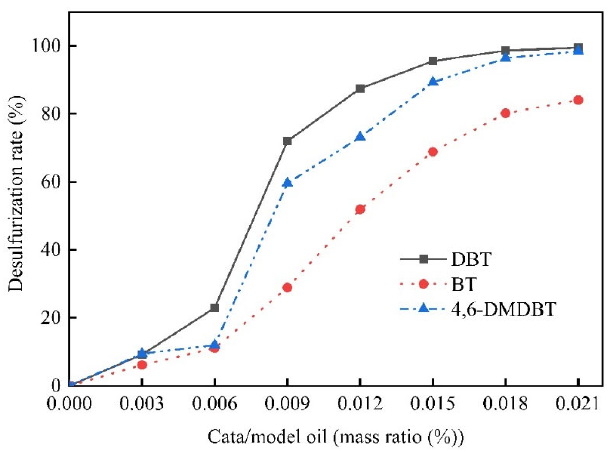
Figure 5. Effect of catalyst/ fuel oil on dibenzothiophene (DBT), benzothiophene (BT), and 4,6-dimethyldibenzothiophene (4,6-DMDBT) desulfurization. Reaction conditions for DBT desulfurization: v (H 2 O 2 )/ v (fuel oil) = 0.30%, 50 ◦ C, 5 min. Reaction conditions for BT desulfurization: v (H 2 O 2 )/ v ( fuel oil) = 0.30%, 50 °C, 8 min. Reaction conditions for 4,6 ‐ DMDBT desulfurization: v (H 2 O 2 )/ v ( fuel oil) = 0.30%, 50 °C, 5 min.